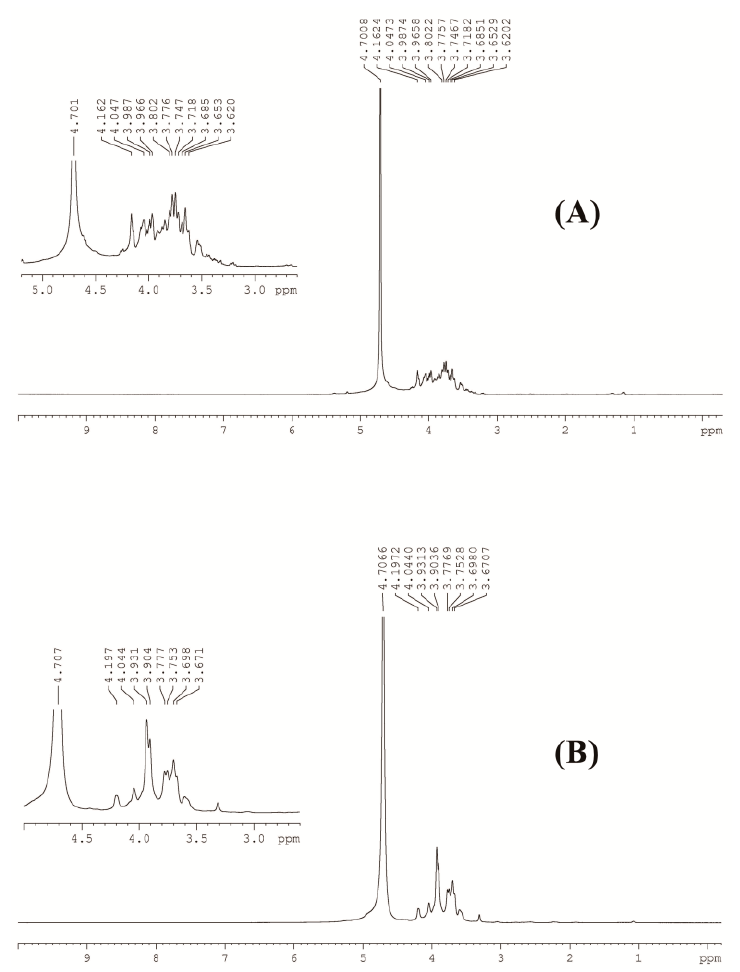
Figure 3. 1 H NMR spectra of GCP-1 ( A ) and GCP-2 ( B ) in D 2 O.